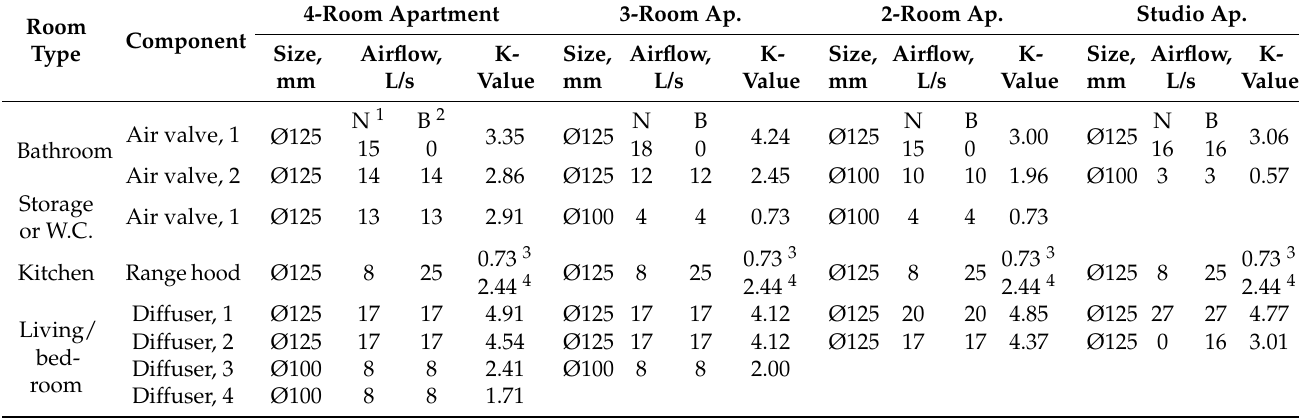
Figure 3. The topology of ductwork in the apartment zones, and the locations of the control and balancing dampers, supply diffusers and exhaust units (valves and hoods) in the apartments. Table 1. Airflow rates, k-values and the sizes of the main ductwork of the different size of apartment